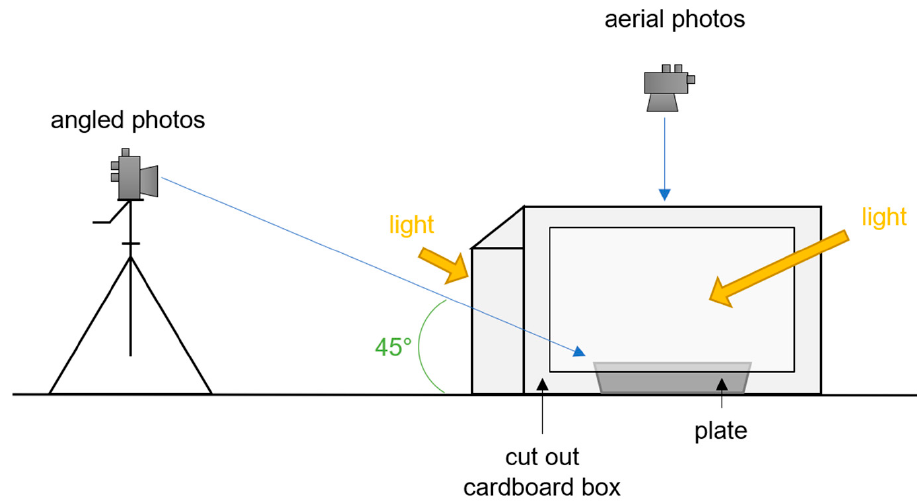
Figure 1. Schema of the installation of the photo box.